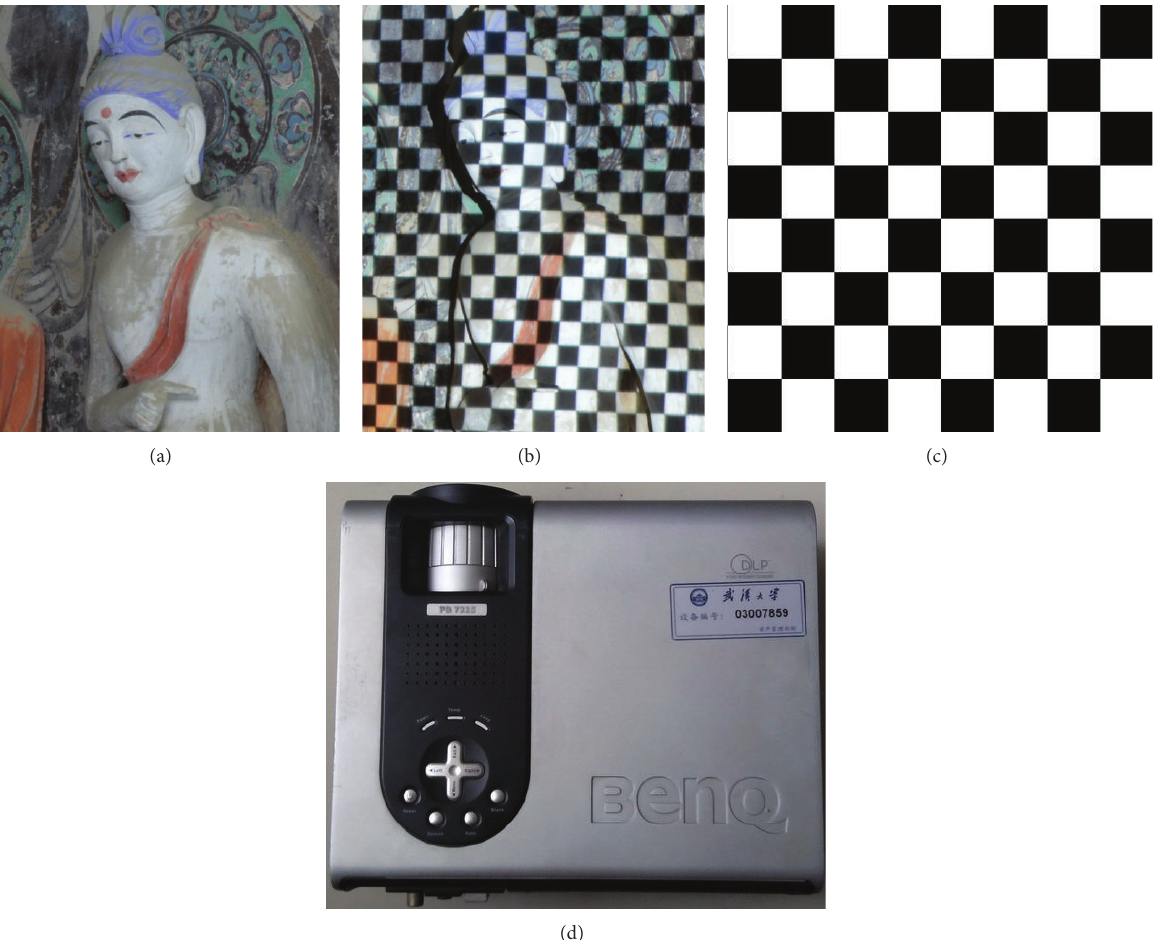
Figure 3: Intensive feature point generation method: (a) poor texture, (b) square projection, (c) the checkerboard, and (d) the projector.